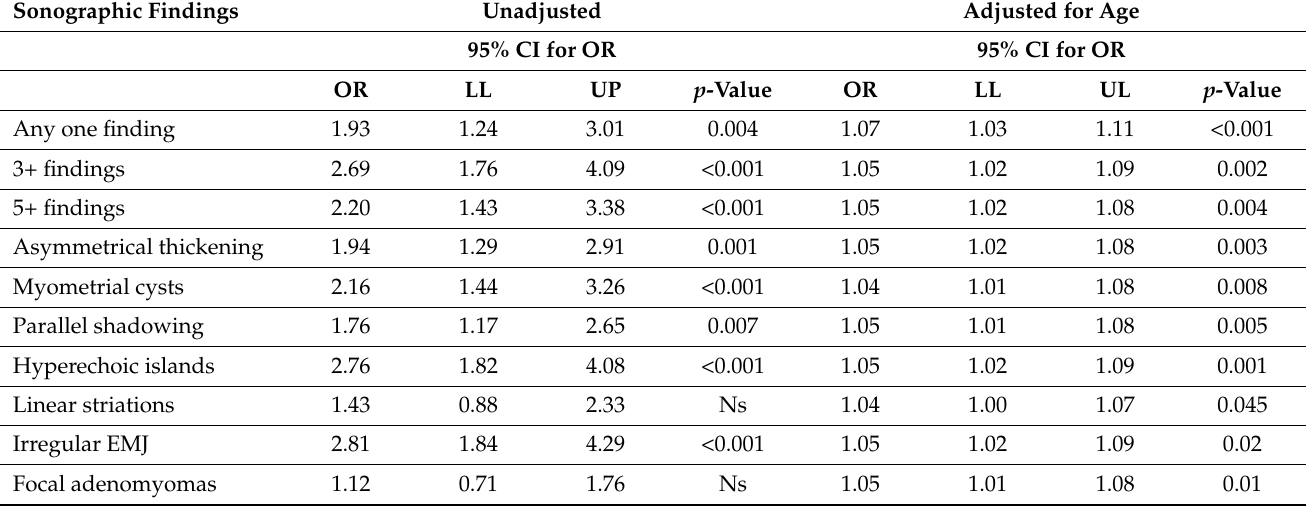
Table 3. Odds ratios for the association between sonographic findings of adenomyosis in women undergoing surgery versus those who did not, and demographic variables using logistic regression for three chosen models: unadjusted-without adjustment for variables; and adjusted for